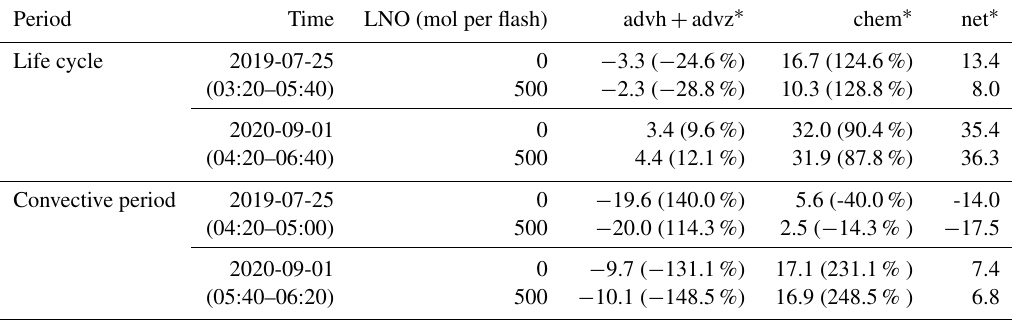
Figure 6. Events on 25 July 2019 (a, c) and 7 September 2020 (b, d) . (a, b) The tropospheric NO 2 slant column density (SCD tropNO filled color) and cloud optical pressure (line color). These white grid cells stand for missing TROPOMI data (no2_scd_flag (cid:54)= 0), as defined in Appendix A. The solid black border is Jiangsu Province. (c, d) The cloud radiance fraction in the NO 2 window and flashes whose color depends on the occurrence time relative to the TROPOMI overpass time. Table 1. Process analysis table for the mean O 3 integrated tendencies